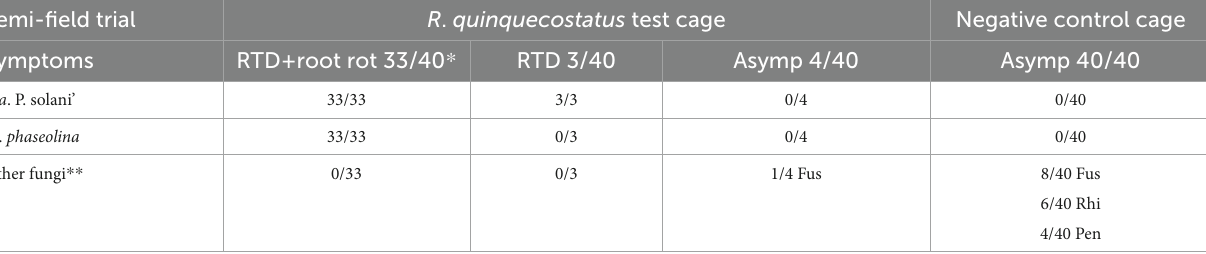
TABLE 1 Sugar beet root symptoms and presence of ‘ Ca . P. solani’ and M . phaseolina in the semi-field experiment with R . quinquecostatus . Semi-field